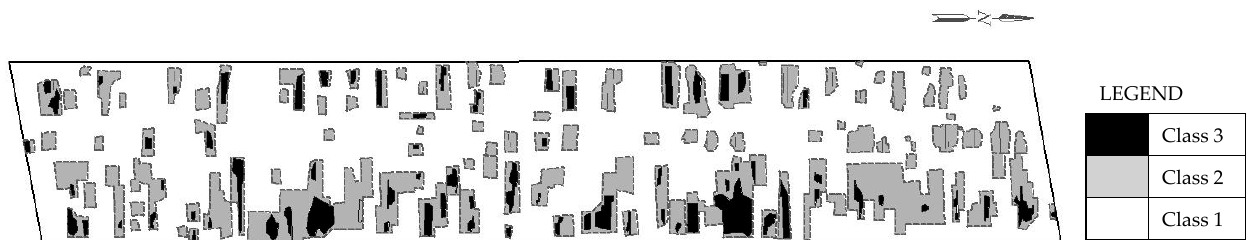
Figure 6. Layout plan showing delamination survey for the FR SB bridge.